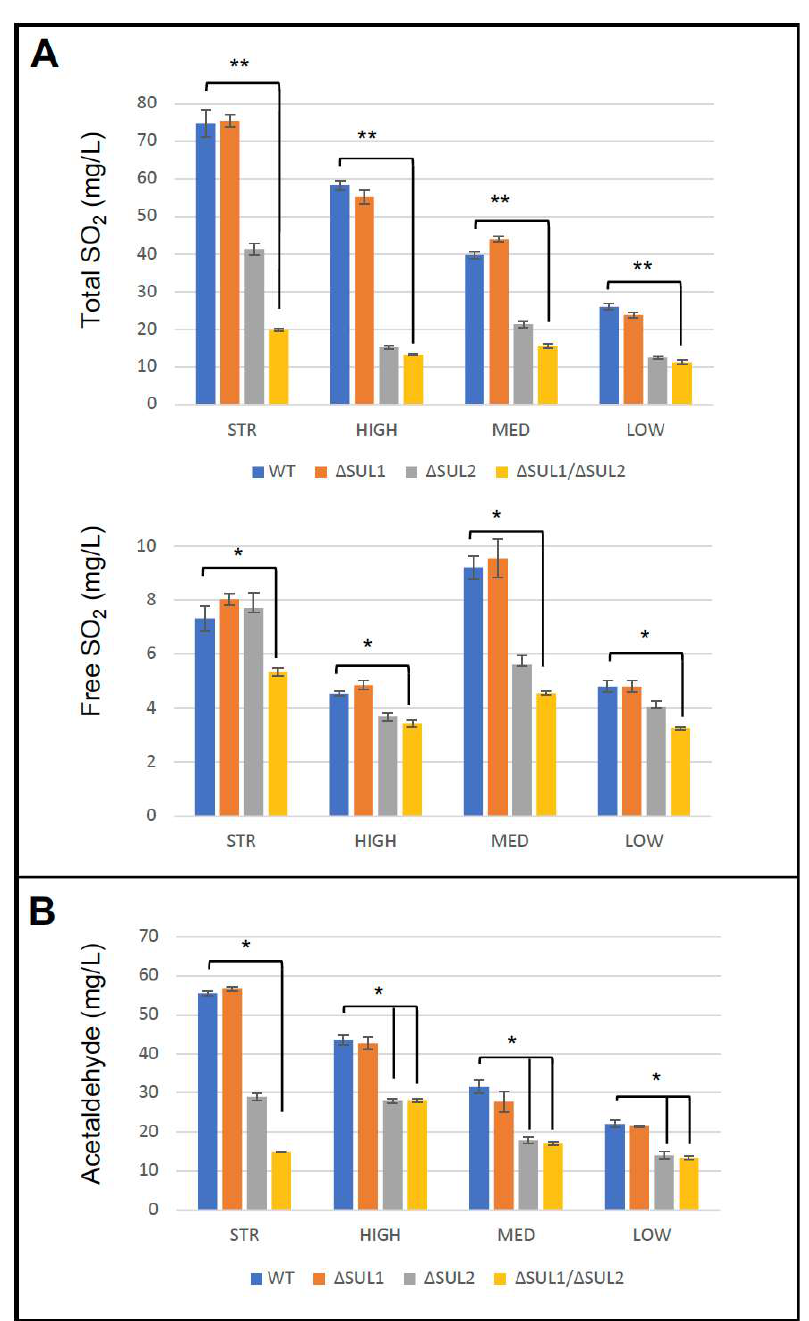
Figure 6. SO 2 and acetaldehyde production by the winery yeast strains deleted for SUL1 and/or SUL2 genes. After the fermentation by the yeast strains (STR, HIGH, MED, and LOW), carrying parental (WT) or mutant alleles ( ΔSUL1, ΔSUL2 , or ΔSUL1/ΔSUL2 ), the levels of total and free SO 2 (panel A) and acetaldehyde (panel B) have been determined as indicated in Materials and Methods. Values are expressed as mean ± S.E ( n = 4). * p -value < 0.05; ** p -value < 0.01, and the Kruskal–Wallis test followed Dunn’s correction.